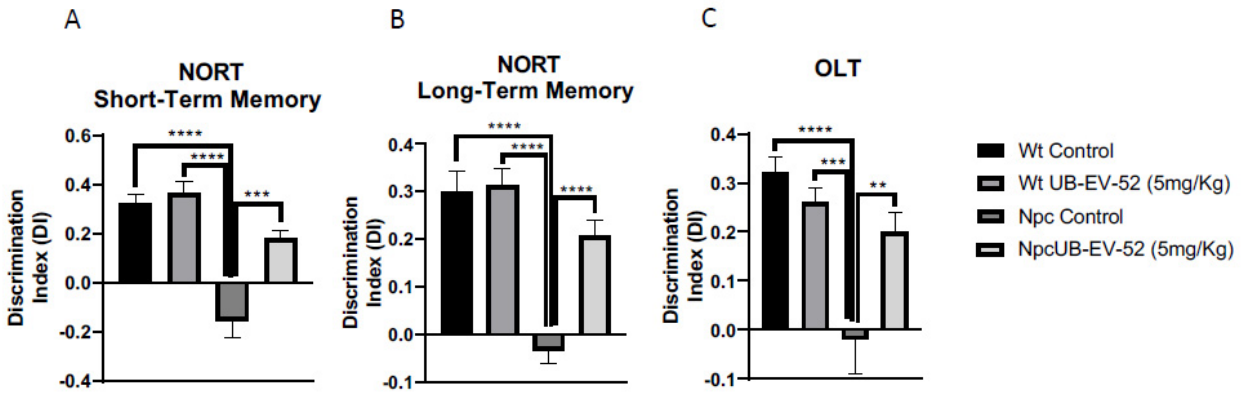
Figure 3. Novel object recognition test (NORT) results for short-term memory in both females and males ( A ), and long-term memory ( B ). Object location test (OLT) results ( C ). Values represented are mean ± standard error of the mean (SEM); n = 48 (Wt control n = 12, Wt UB-EV-52 (5 mg/kg) n = 12, Npc control n = 12, and Npc UB-EV-52 (5 mg/kg) = 12); discrimination index (DI). ** p < 0.01; *** p < 0.001; **** p < 0.0001.